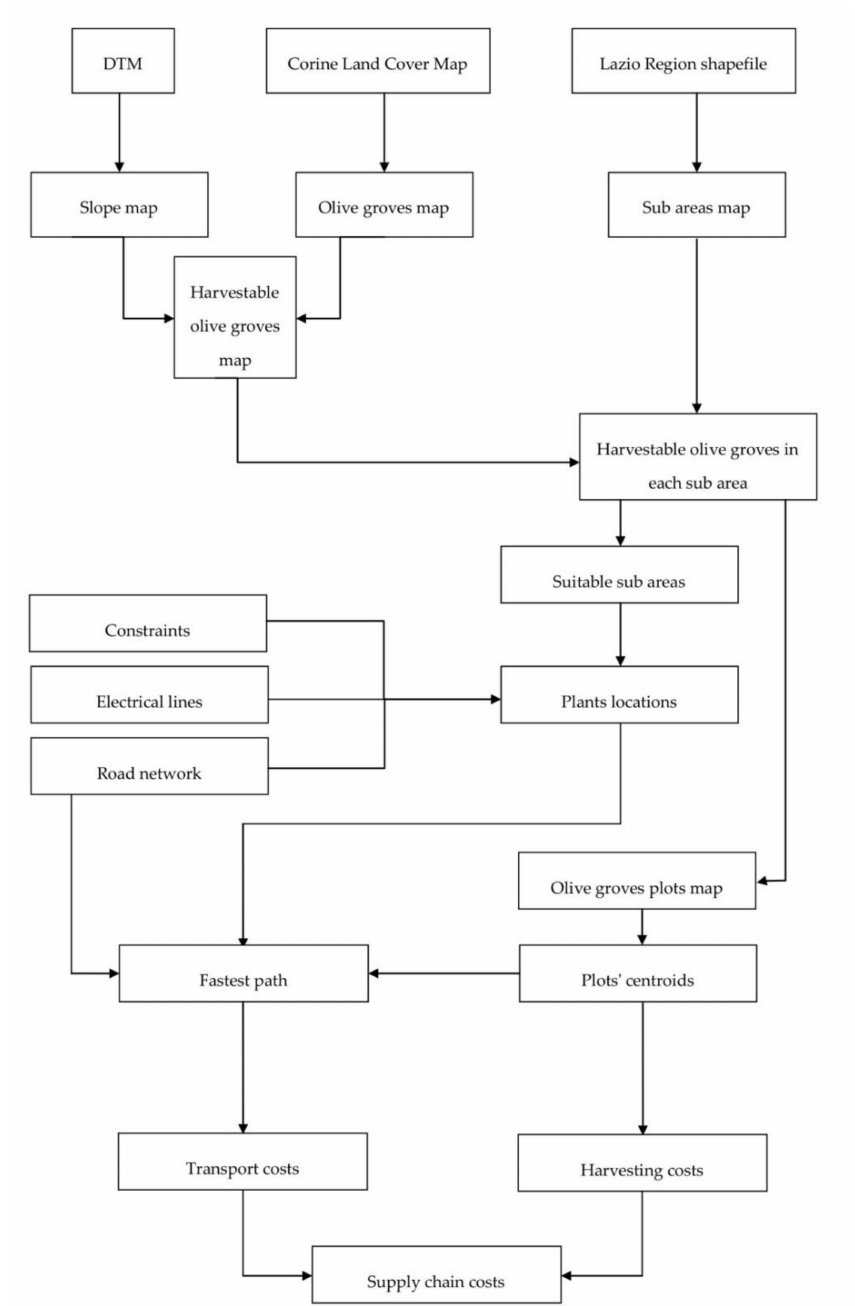
Figure 3. Graphical block diagram of the GIS